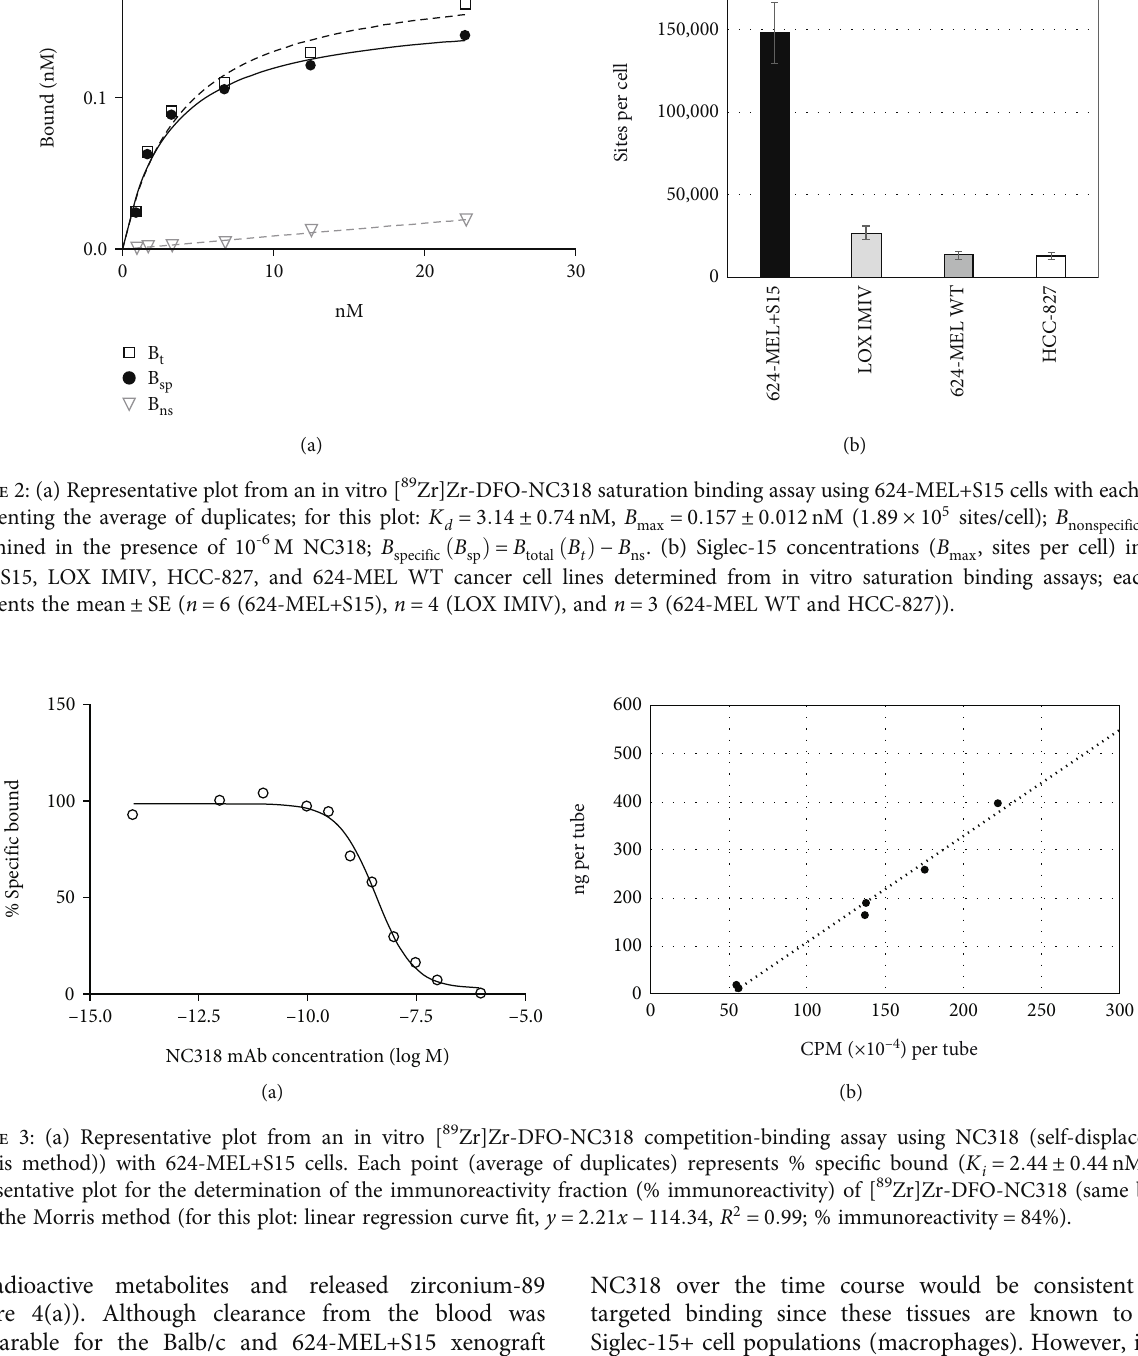
Figure 3: (a) Representative plot from an in vitro [ 89 Zr]Zr-DFO-NC318 competition-binding assay using NC318 (self-displacement (Morris method)) with 624-MEL+S15 cells. Each point (average of duplicates) represents % speci fi c bound ( K i = 2 : 44 ± 0 : 44 nM). (b) Representative plot for the determination of the immunoreactivity fraction (% immunoreactivity) of [ 89 Zr]Zr-DFO-NC318 (same batch) using the Morris method (for this plot: linear regression curve fi t, y = 2 : 21 x – 114 : 34 , R 2 = 0 : 99 ; % immunoreactivity = 84 % ).